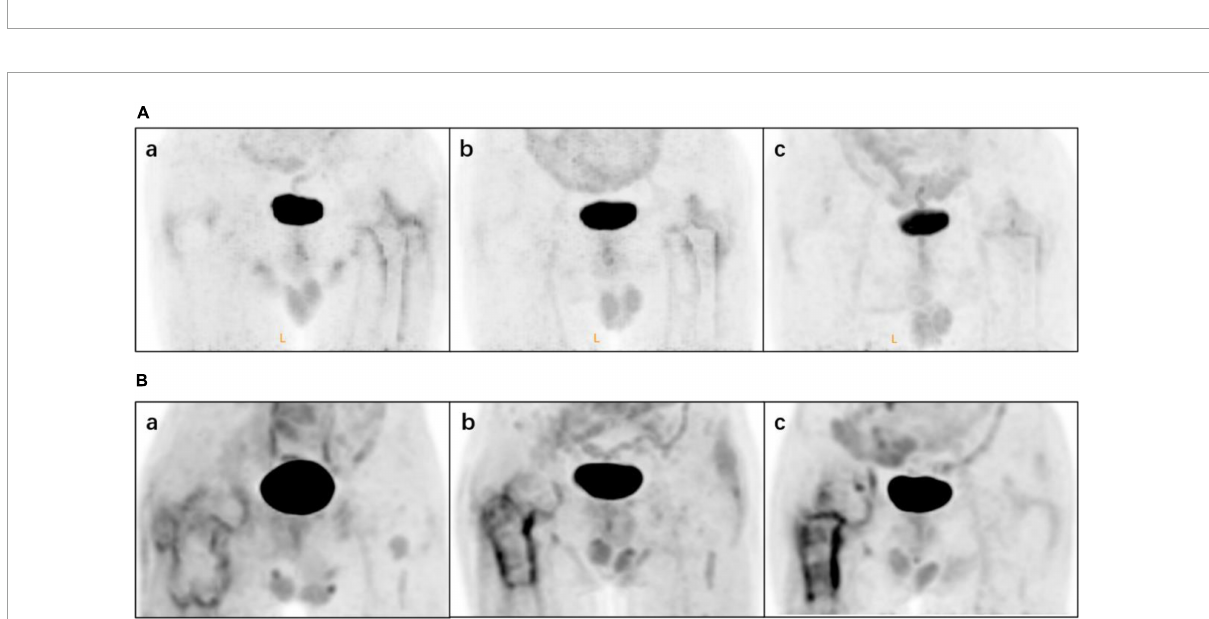
FIGURE7 Different characteristics of wear cases.